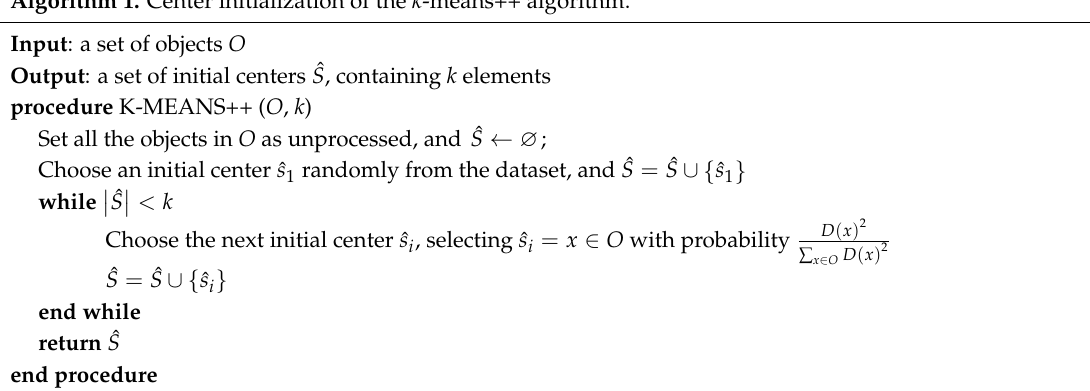
Algorithm 1. Center initialization of the k -means++